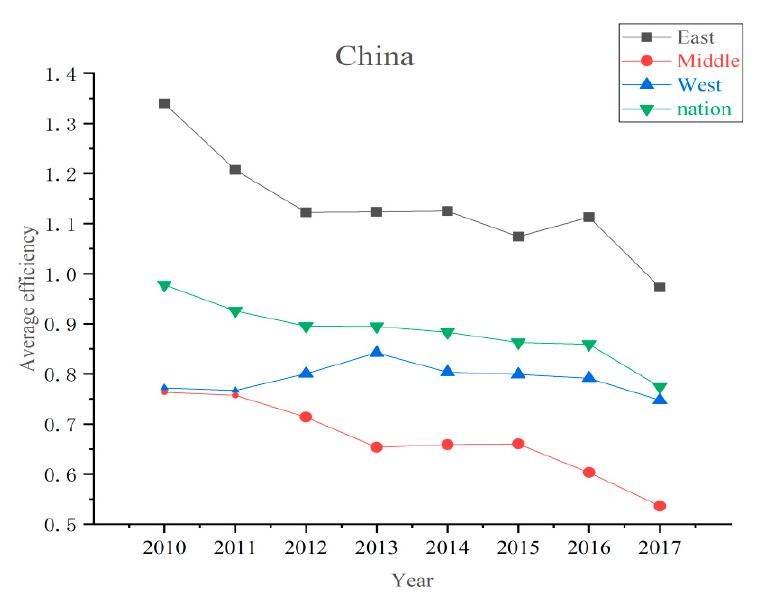
Figure 3. Average e ffi ciency from 2013–2016 for the east, middle, west, and nationwide Figure 3. Average efficiency from 2013–2016 for the east, middle, west, and nationwide (China).